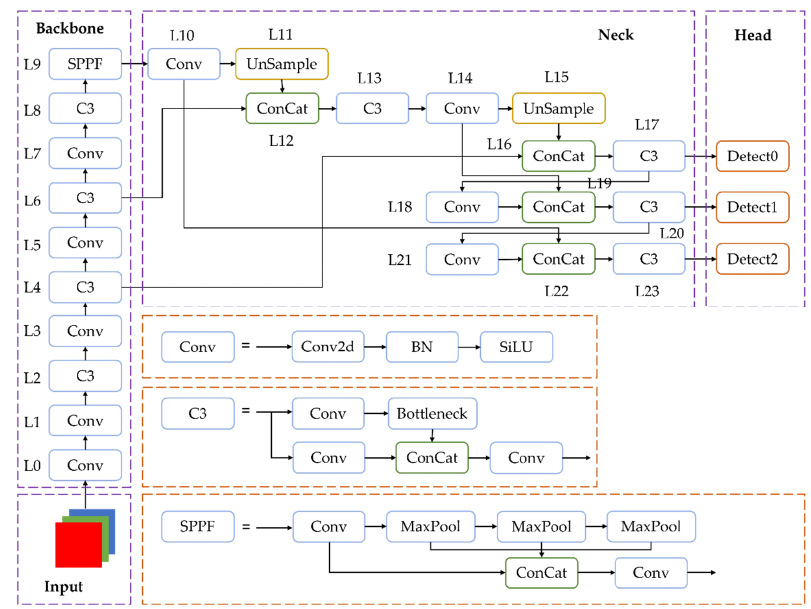
Figure 2. Structure of YOLOv5s model version